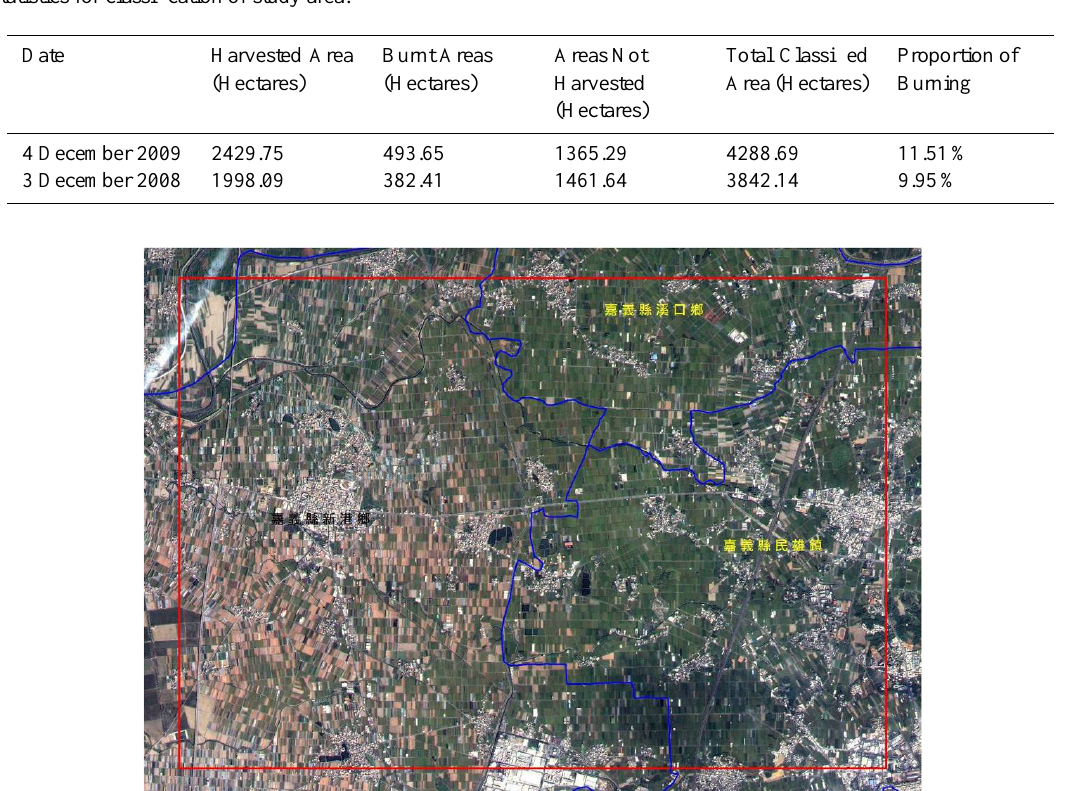
Table 1. Statistics for classification of study